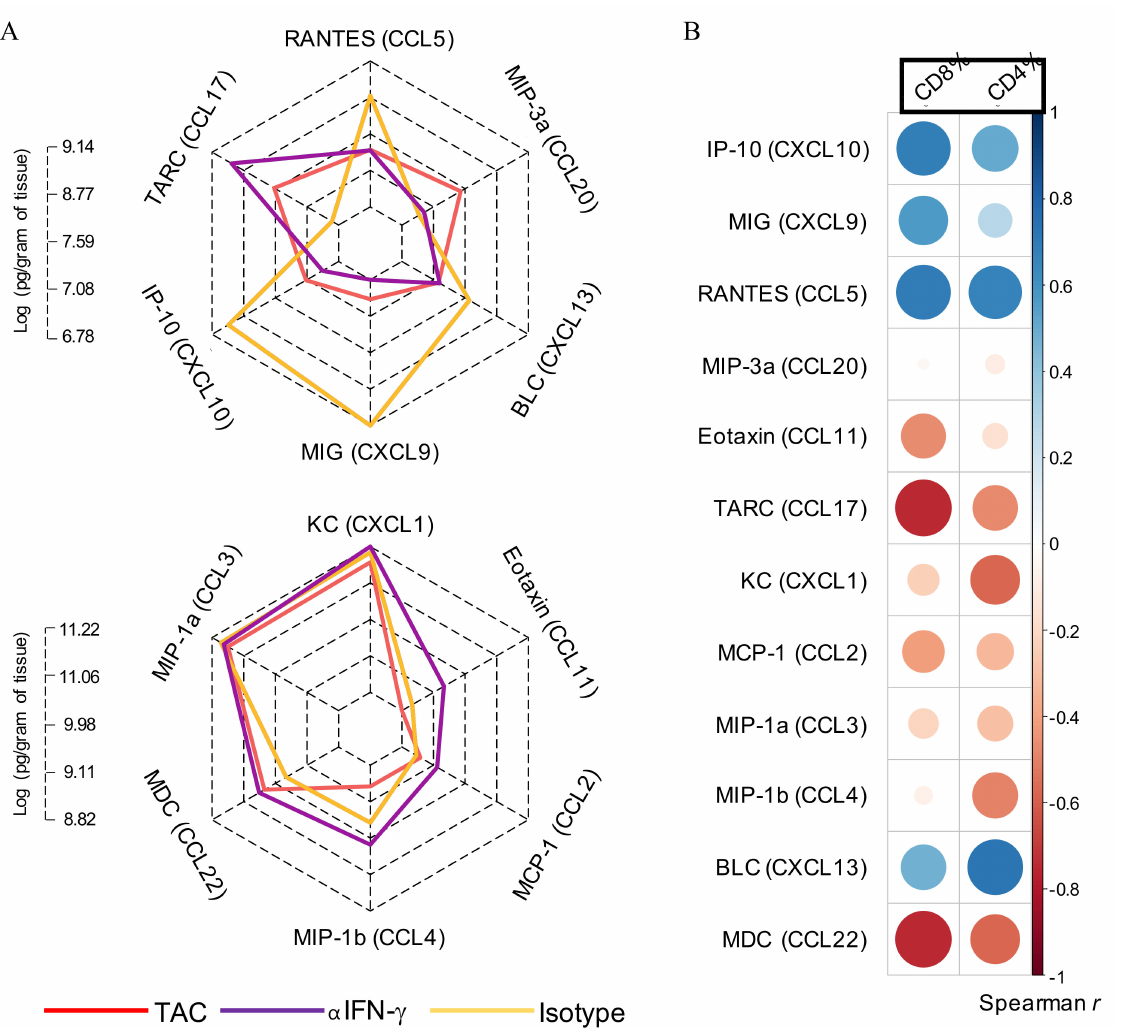
Figure 6. IFN- γ neutralisation alters chemokine abundance within the tumour microenvironment. ( A ) Homogenized tumour samples were analyzed by cytometric bead array to determine chemokine content. Radar charts of mean log- abundance values of chemokines. The axis length at each radius ranges from the minimum to maximum magnitude of log-abundance values across the analytes and the axis labels mark the log-abundance values at quartile intervals (0%, 25%, 50%, 75%, 100%). ( B ) Correlation analysis of chemokine expression with T cell infiltrate. Spearman correlation r values are plotted as a heatmap with the area of each circle corresponding to the strength of the correlation. Blue = positive correlation, Red = negative correlation. The correlation and statistical testing was performed using the rcorr function embedded in the Hmisc R package. TAC =